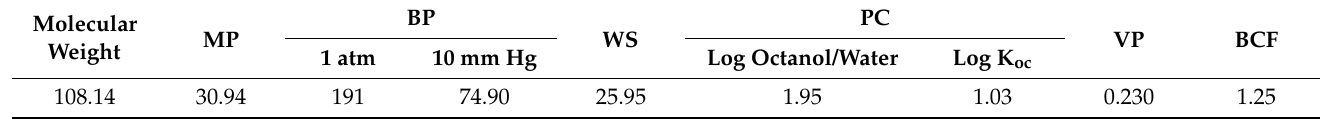
Table 3. Selected physical and chemical properties of o